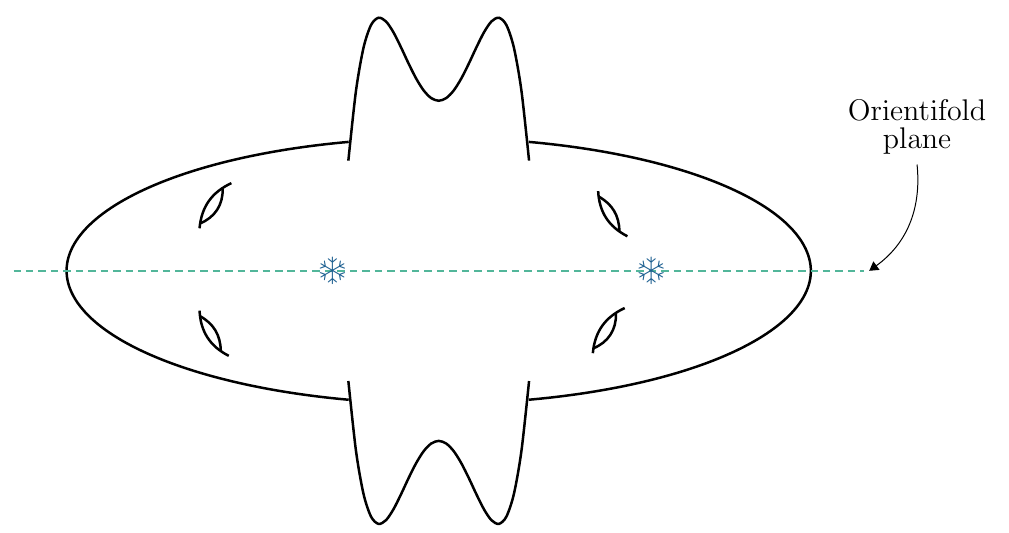
Figure 3 . A representation of the orientifold projection acting on a CY manifold with two double throats. The blue dashed line represent the fixed locus of the projection. The double throats are mapped to each other by the Z symmetry. Snowflakes depict frozen 2